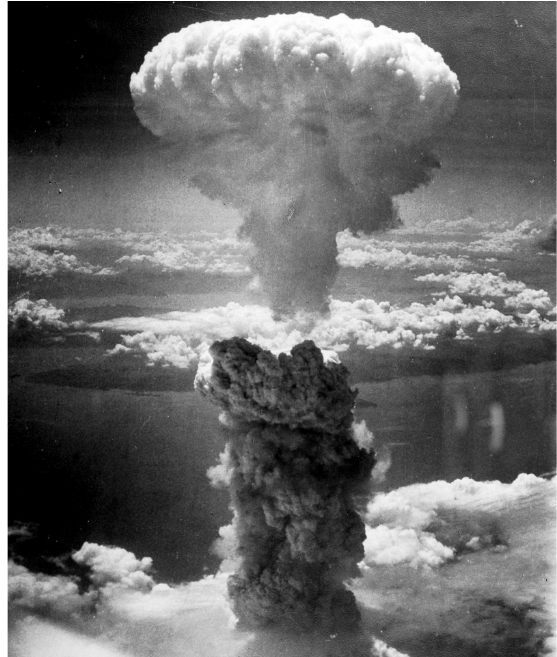
Figure 1: Atomic cloud rises over Nagasaki, Japan, 9 August 1945. Image courtesy of the National Archives, RG 208: Records of the Office of War Information,